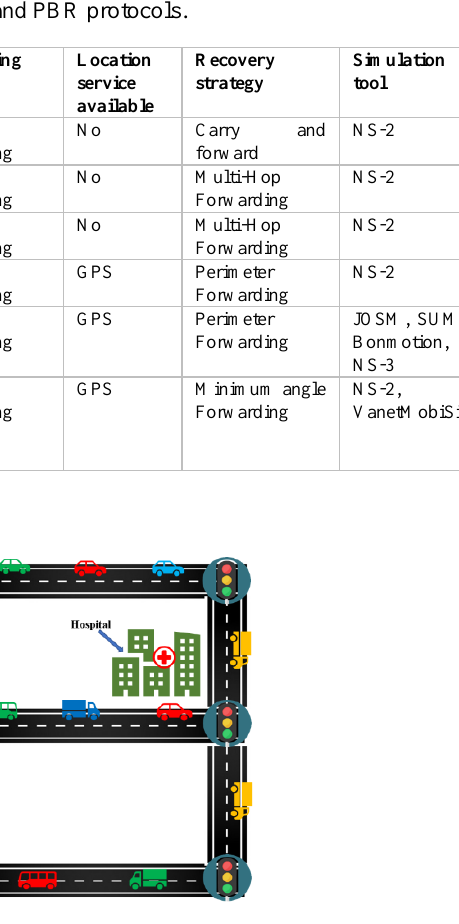
Figure 2. Simulation scenario of a road